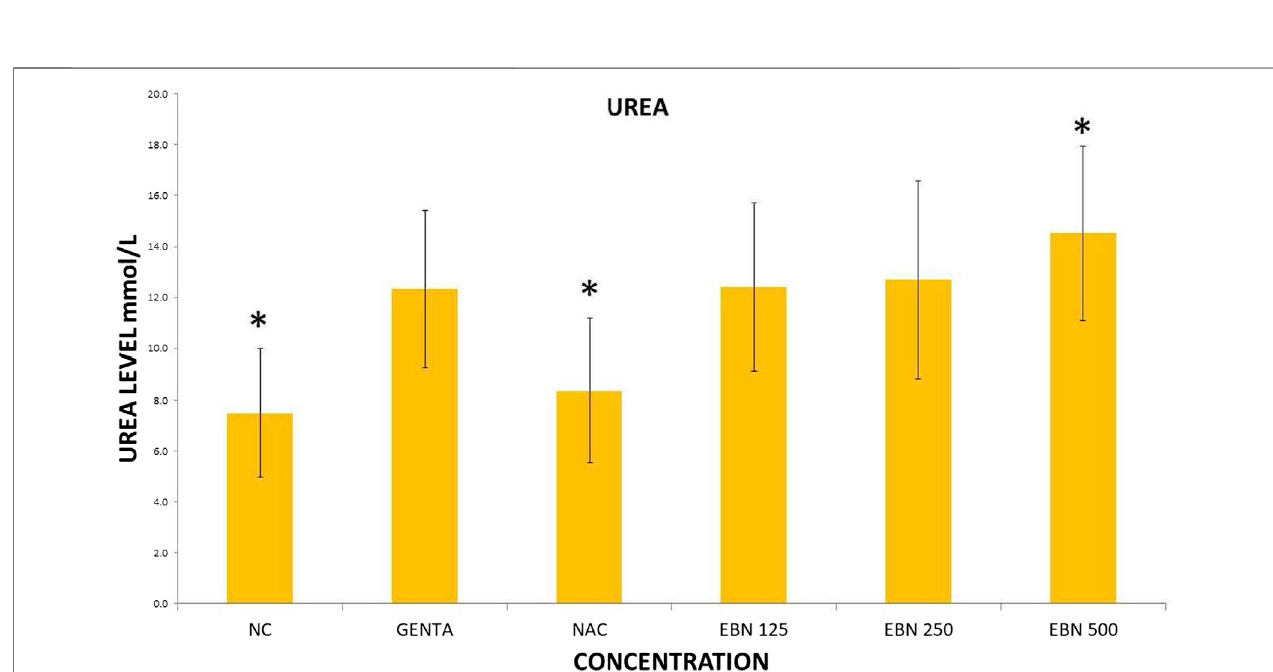
FIGURE 8 | Changes of serum urea changes vs. different pre-treatment group (* p < 0.05 compare to gentamicin group).